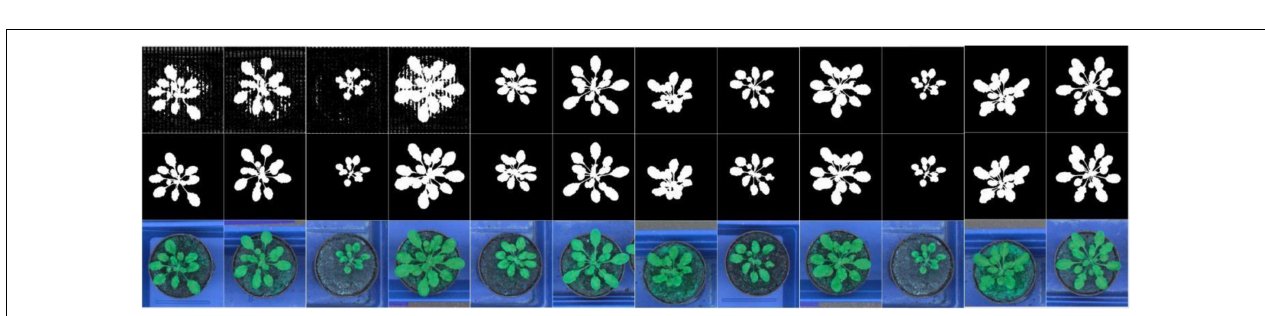
FIGURE 7 | Visualization for the feature extraction process of our method, arranged by time series from the early to late epochs. The first to third line images respectively show the predicted images, ground truth images and transformed RGB images.